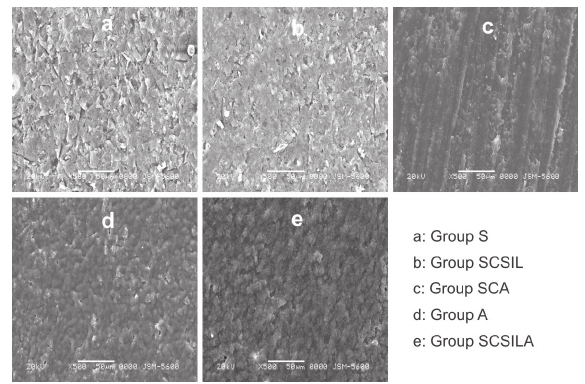
Figure 1- Scanning electron microscopy images of the experimental groups (original magnification ×500). Note difference in surface texture between images, indicating that the sandblasted (Group S) and silica coated followed by the silanization (Group SCSIL) groups have rougher surfaces than the other groups Figure 2- Transmittance FTIR peaks (cm -1 ) and group/structure of the untreated PMMA, the soft liner, the adhesive